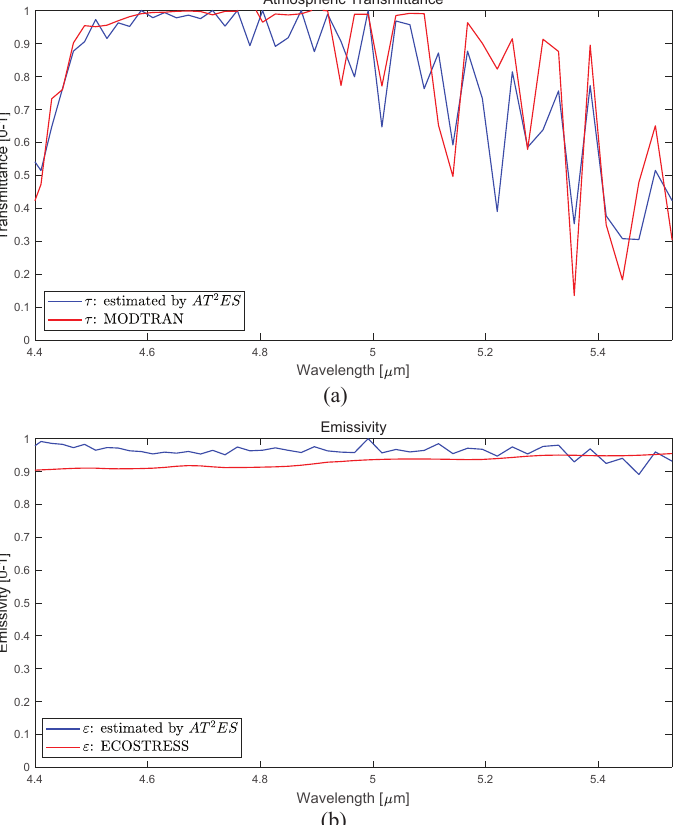
Figure 26. Asphalt region: Comparison of atmospheric transmittance and emissivity estimation by the proposed AT 2 ES and MODTRAN: ( a ) spectral atmospheric transmittance, and ( b ) spectral